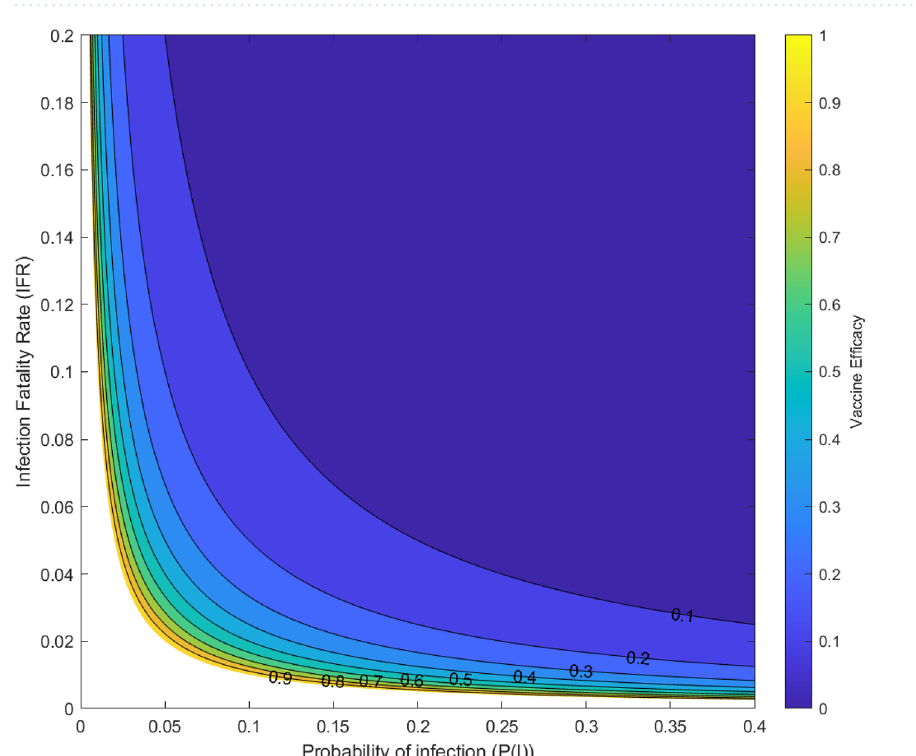
Figure 2. Contour plot of Vaccine Efficacy (VE) versus probability of infection (P(I)) and Infection Fatality Rate (IFR), for ranges of these parameters relevant to COVID-19 ( 0 ≤ P(I) ≤ 0.4 ; 0 ≤ IFR ≤ 0.2 ), given a Serious Adverse Event Rate (SAER) of 0.1%. The VE = 0.1 contour includes more than half of this parameter region, and so Utility > 0 for a vaccine efficacy of 10% in this region of values. Further increments of VE include progressively smaller additional proportions of this field of (P(I), IFR). Note the unshaded region is where vaccination is not beneficial even with a perfectly effective vaccine, given by 0.001 ≥ P(I) · IFR : this is the region where the risk of disease is lower than than the SAER of the